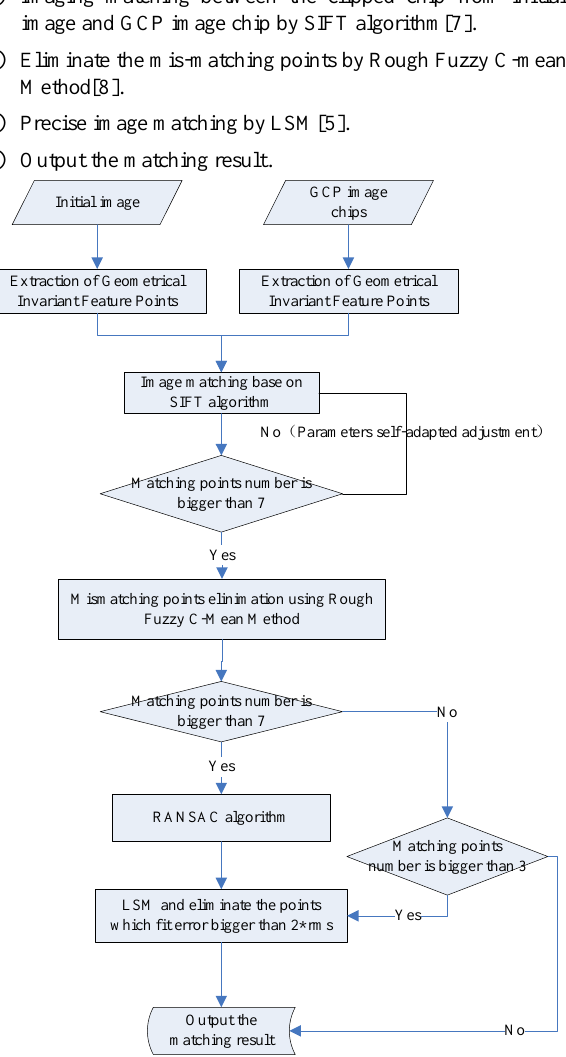
Figure 3. The work-flow of auto-matching GCP image